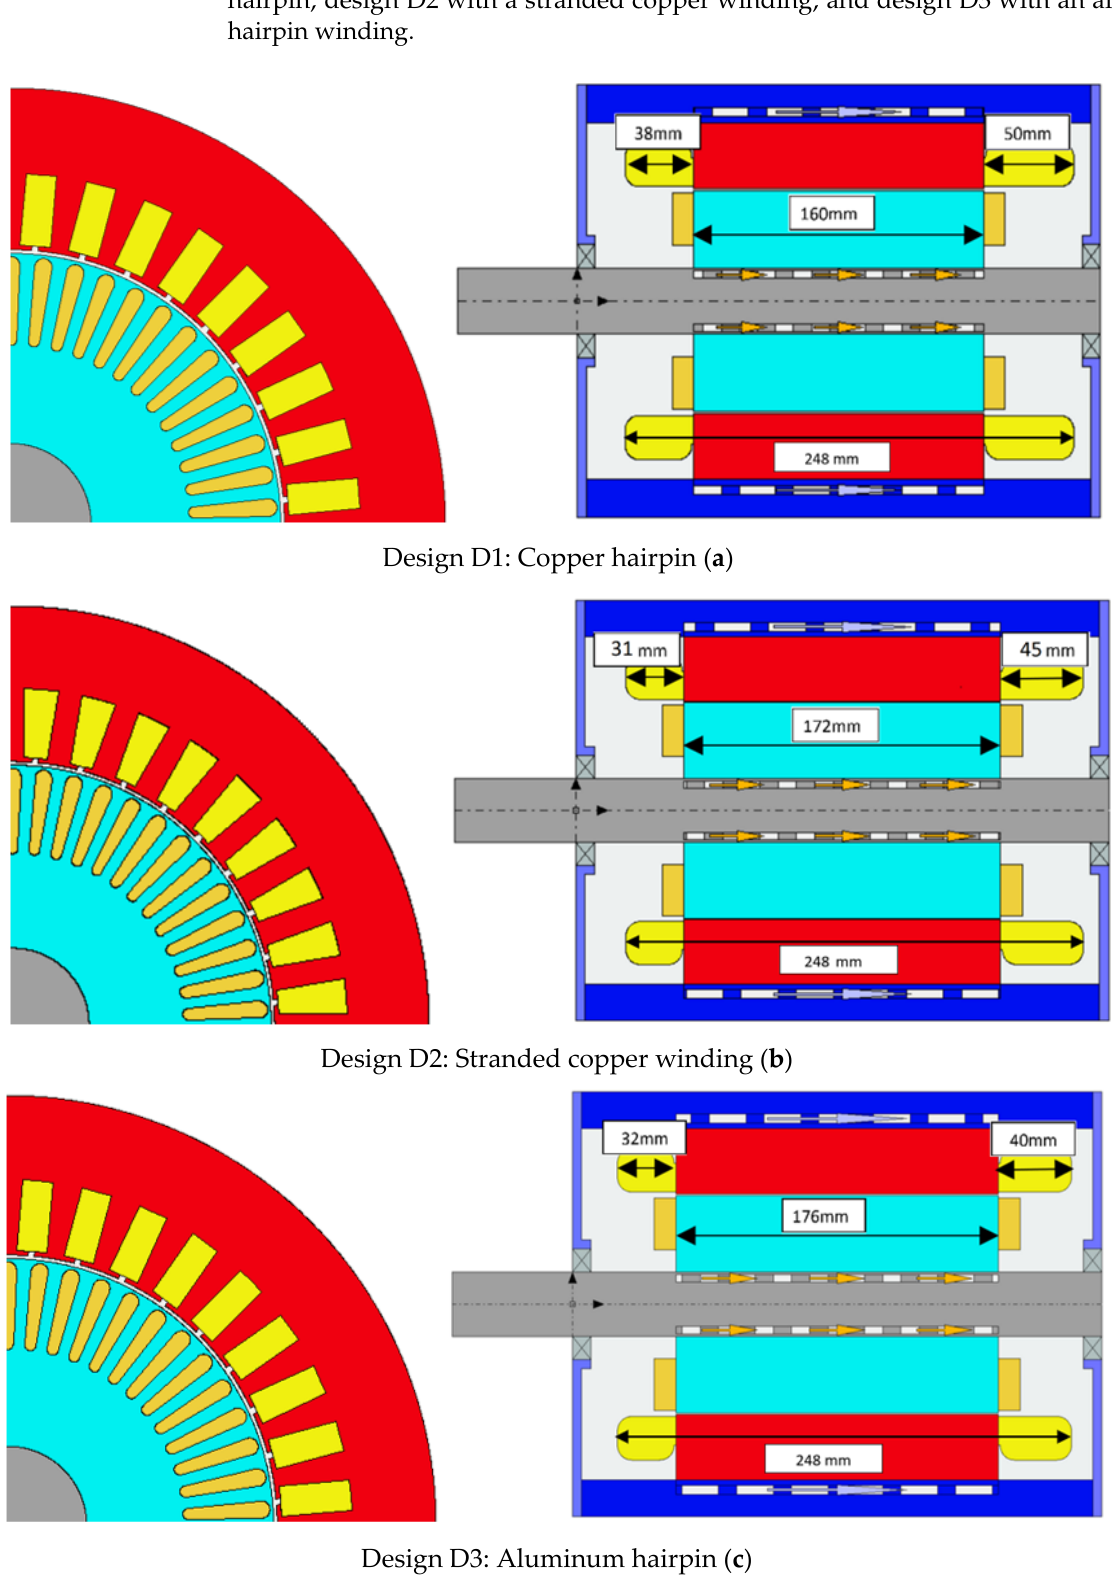
Figure 2. Radial and axial cross-sections of the IM designs: ( a ) design D1; ( b ) design D2; ( c ) design D3.